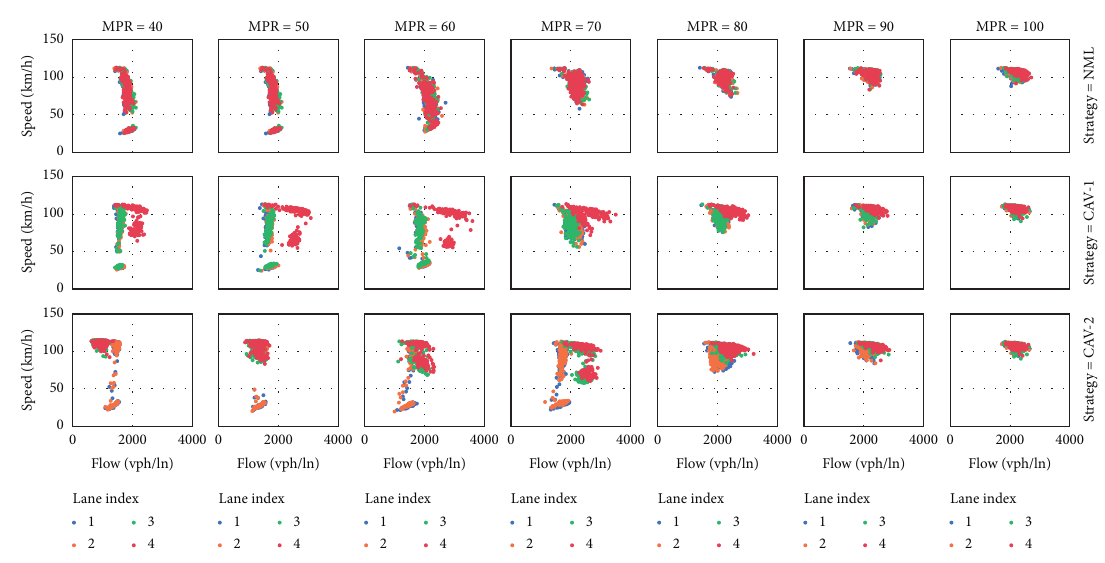
Figure 2: Speed-flow